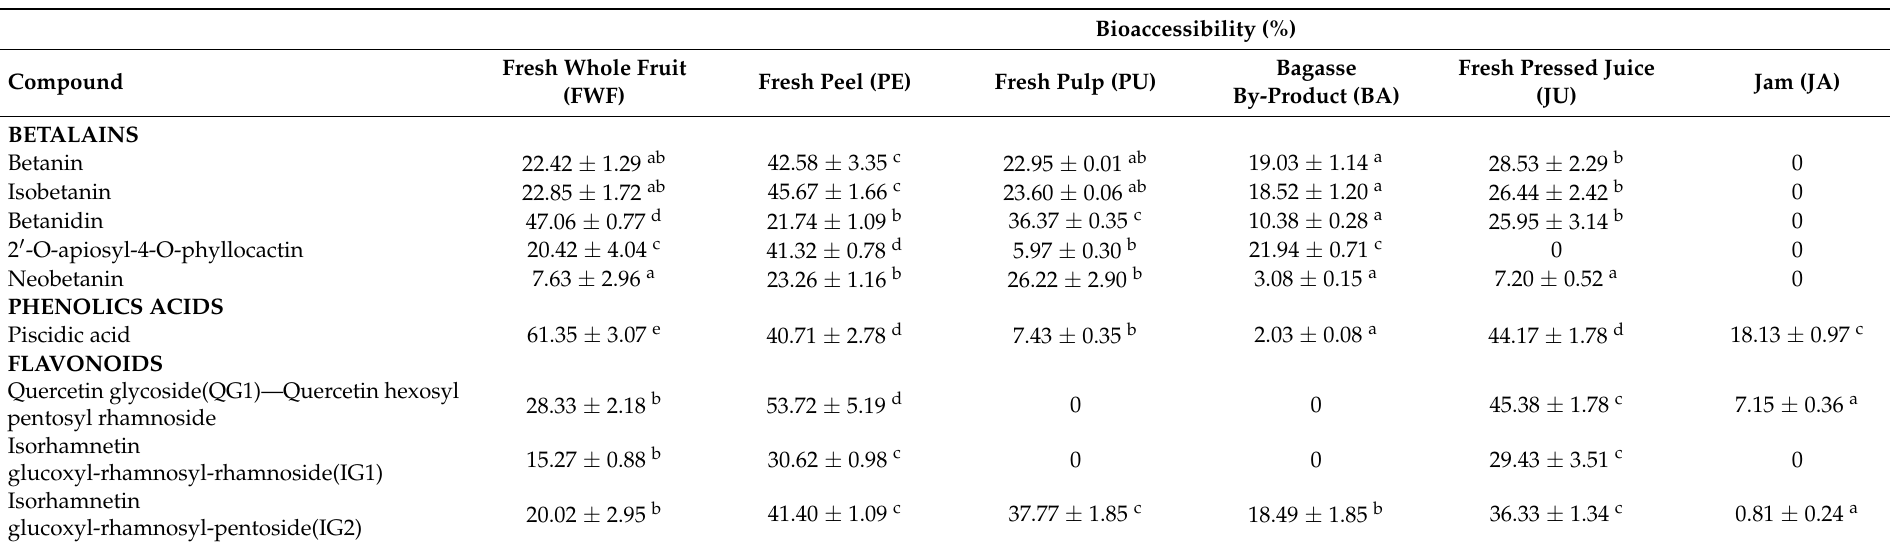
Table 3. Bioaccessibility of the most abundant betalain and phenolic compounds in Opuntia stricta var. Dillenii fruit tissues (peel, pulp, and whole fruit), jam production products (intermediate juice and jam), and by-product (bagasse) during in vitro gastrointestinal static